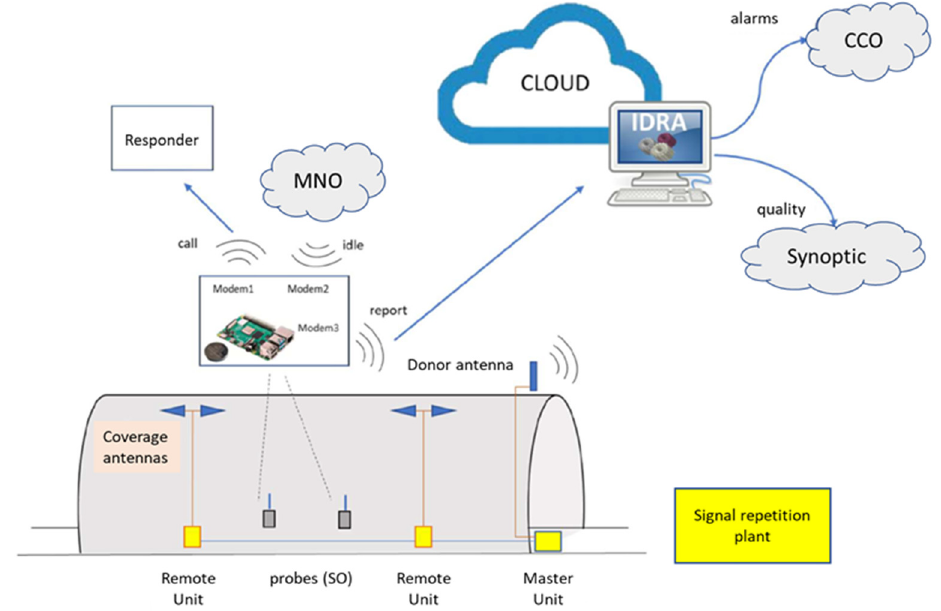
Figure 4. TEZE system conceptual block-diagram in a tunnel installation.